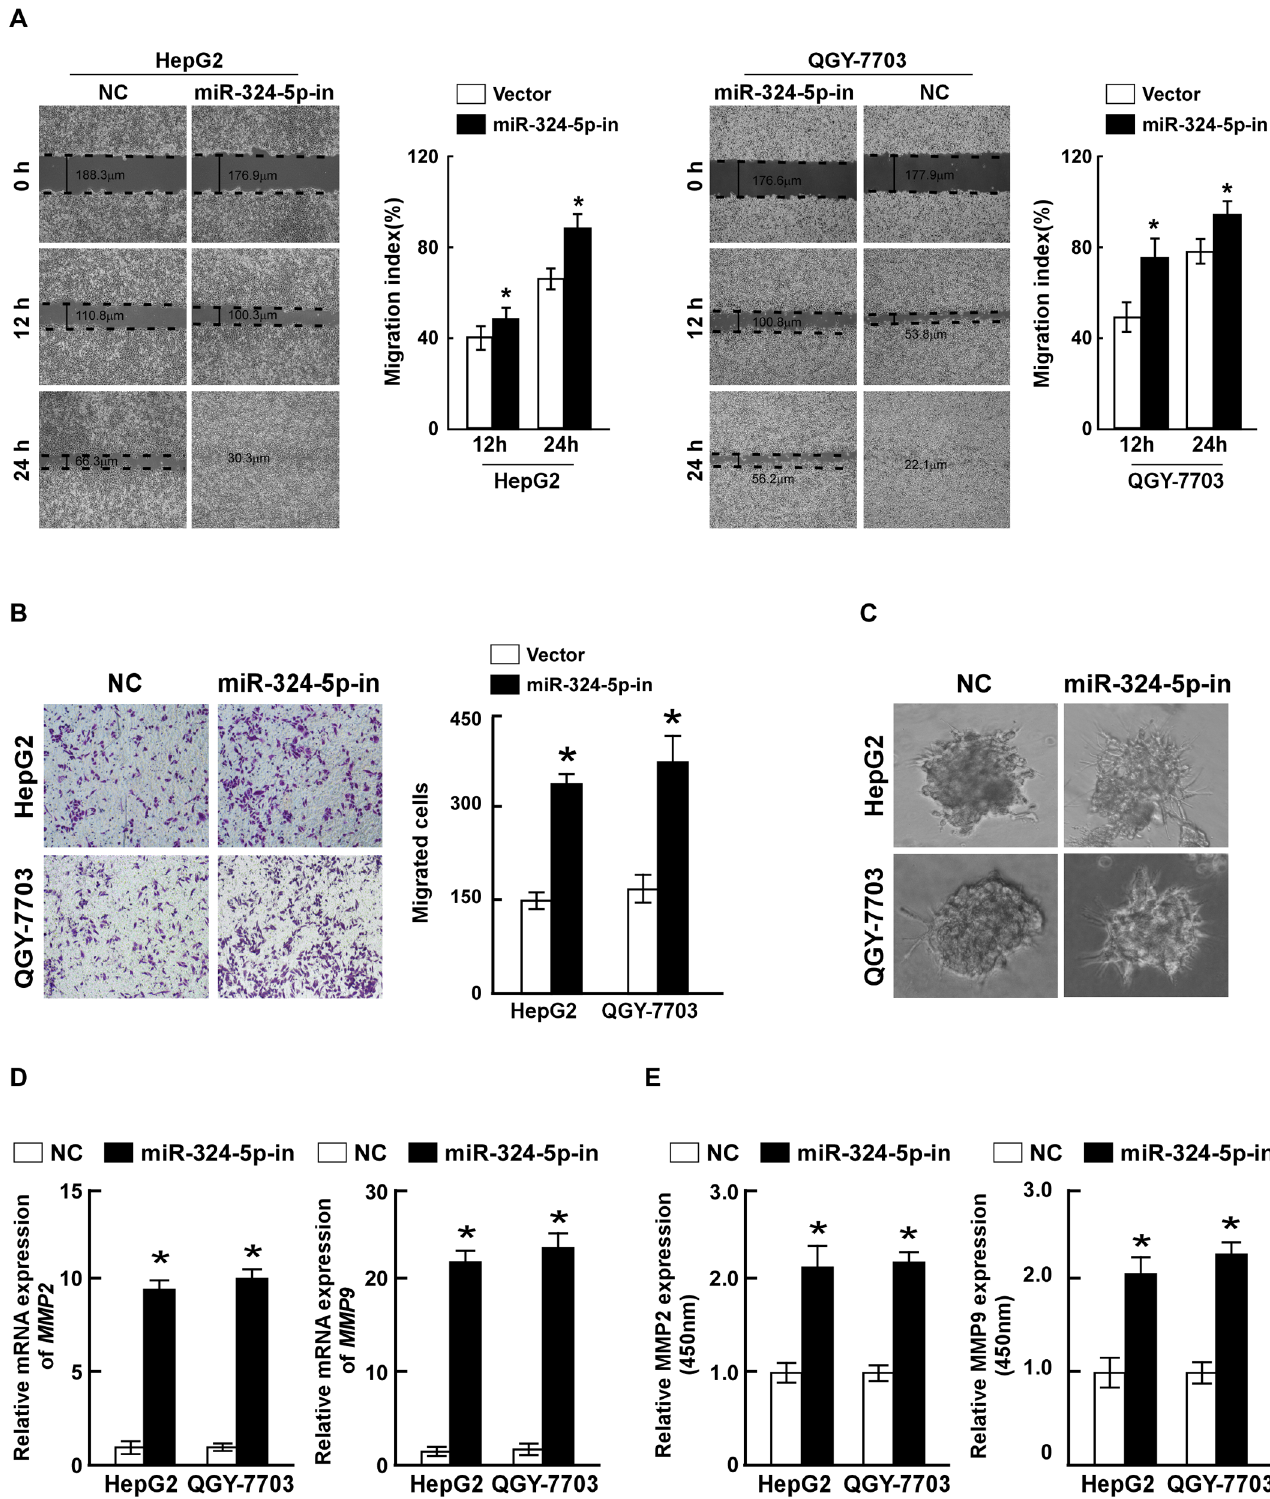
Fig 3. Inhibition of miR-324-5p promotes invasion and migration of HCC cells. A. Representative micrographs (left) and quantifications (right) of wound healing assay of the HCC cells, transfected with miR-324-5p inhibitor or negative control (NC). Wound closures were photographed at 0, 12 and 24 hours after wounding. B. Representative micrographs (left) and quantifications (right) of indicated invading cells in a Matrigel-coated Transwell assay. C. Representative micrographs of indicated cells grown on Matrigel for 10 days in 3-Dimensional Cell Culture. D. Real-time PCR analysis of MMP2 and MMP9